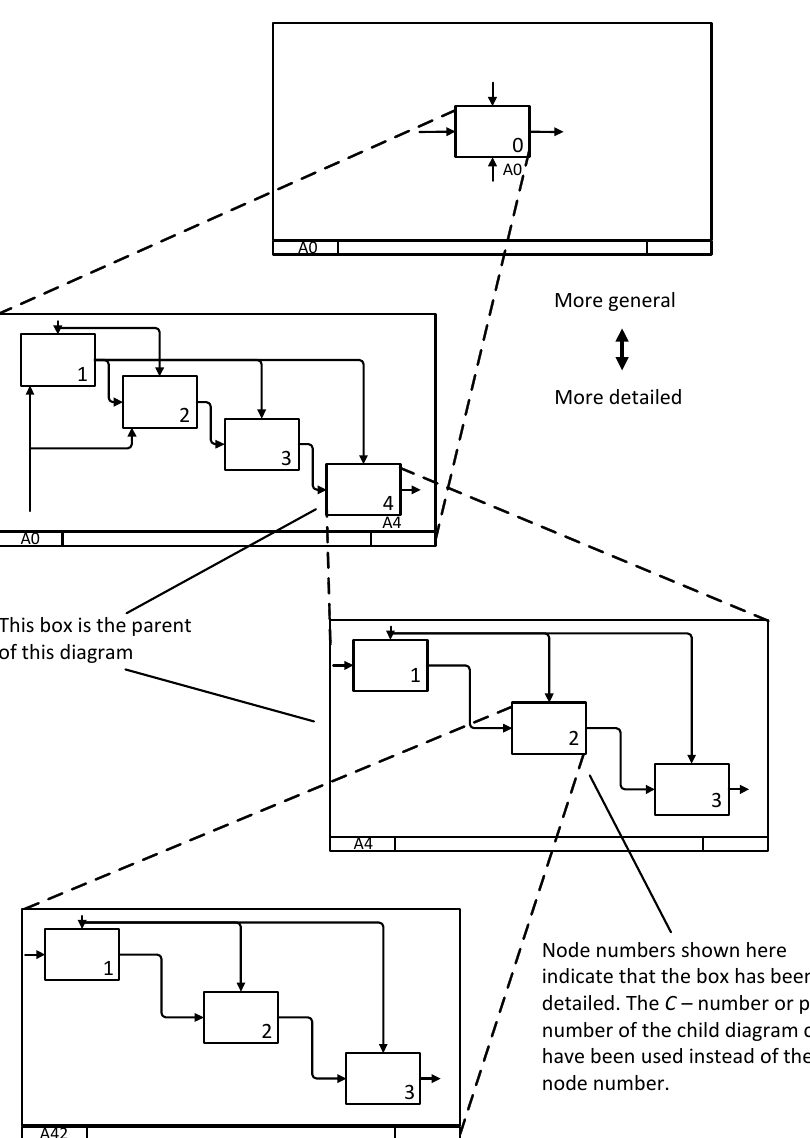
Figure 2. Decomposition in